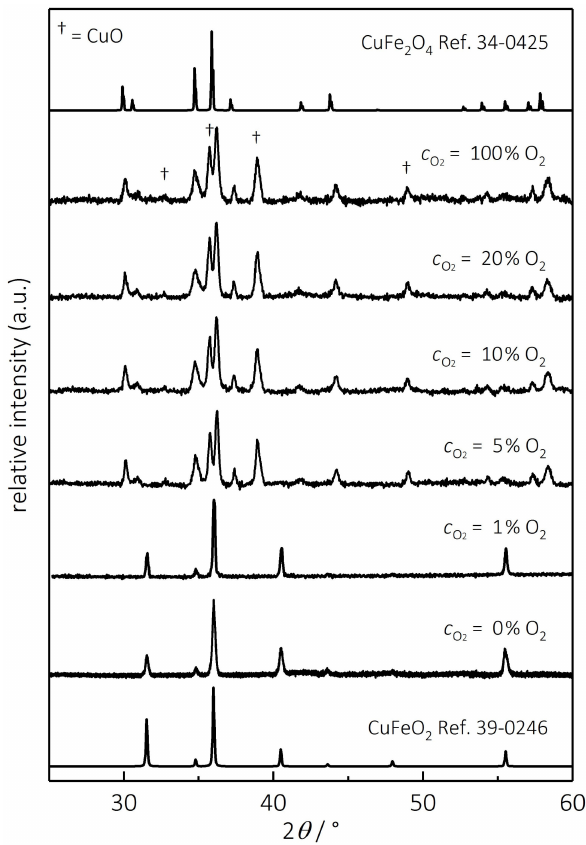
Figure 3. XRD patterns of CuFeO 2 annealed in 900 ◦ C for 12 h under different oxygen–nitrogen gas mixtures. Additionally, the reference spectra of CuFeO 2 (JCPDS = 39-0246) and CuFe 2 O 4 (JCPDS = 34-0425) are